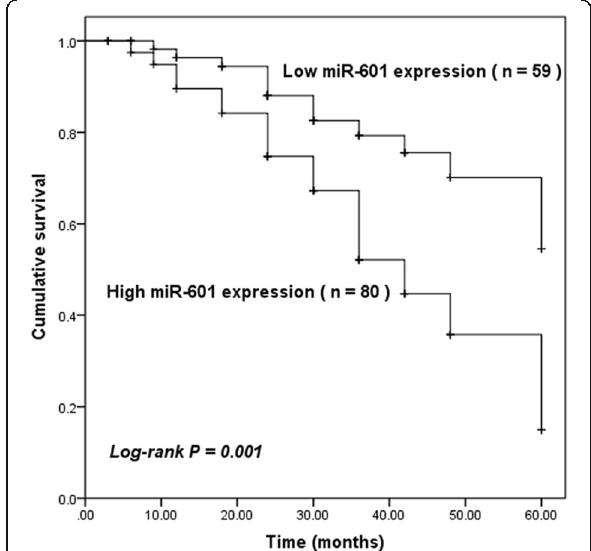
Fig. 2 Kaplan-Meier survival analysis for the GC patients based on the expression of miR-601. Patients with high miR-601 expression had shorter survival time than those with low miR-601 expression (log-rank P = 0.001)